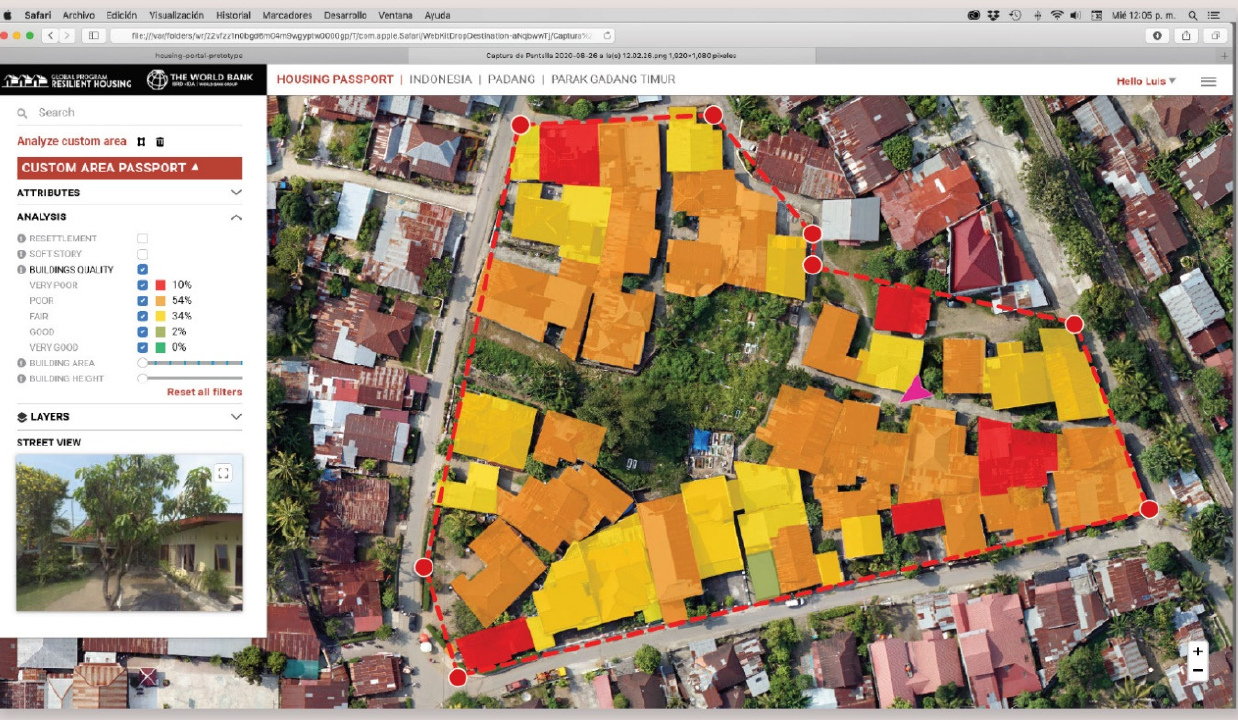
Figure 2. Results of building quality assessment, Penang, Indonesia [source World Bank].